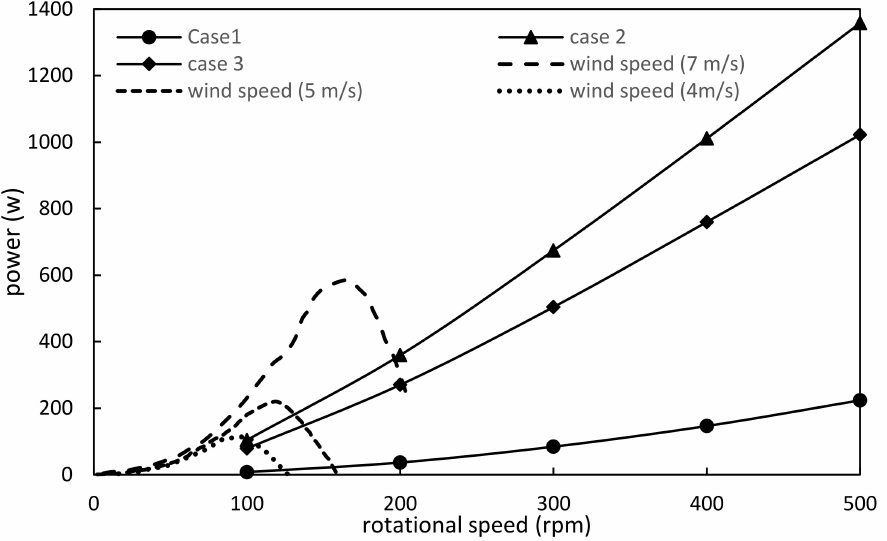
Figure 18. Comparison between power produced by wind turbine and needed power for each case at different rotational